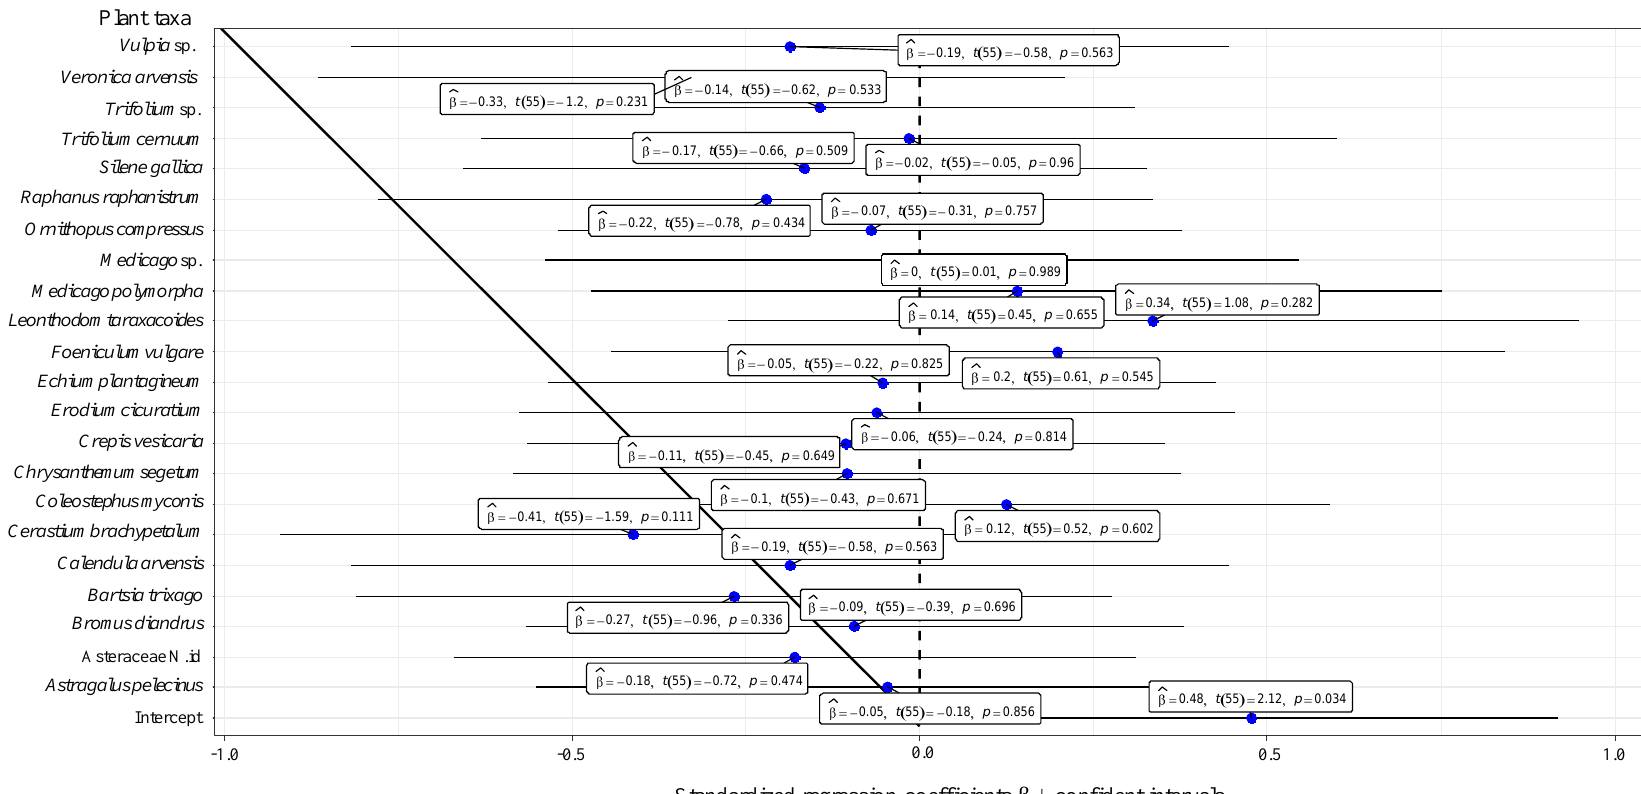
Figure 2. Estimated regression coefficients (β), t values (degrees of freedom), and p -values (within boxes) for the weighted number of nymphs by the plant cover as a function of each taxa identity in an abandoned olive orchard on 21 April 2017, obtained with linear mixed models. Blue points represent β and bars the confidence intervals. The dotted vertical line indicates the 0 value for the standardized regression coefficients. AIC: Akaike information criterion. BIC: Bayesian information criterion.